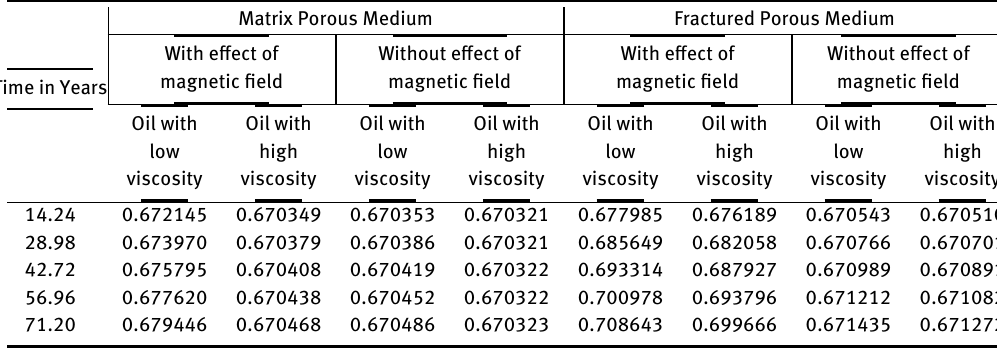
Table 1: Numerical values of saturation rate in volcanic sand in fractured and matrix porous media having low and high viscous reservoir fluids with and without magnetic field effect